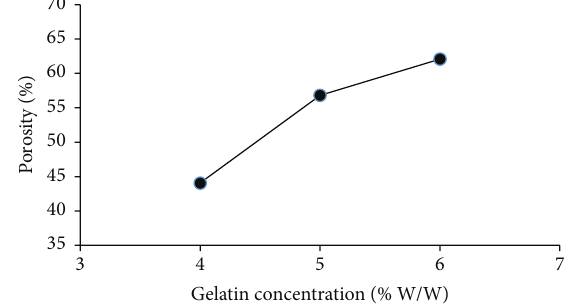
Figure 13: Effect of acrylic acid concentration on porosity of AA/Gelatin hydrogels.